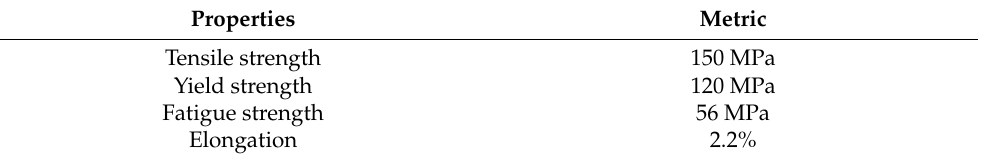
Table 2. Mechanical strength of AA 8079.